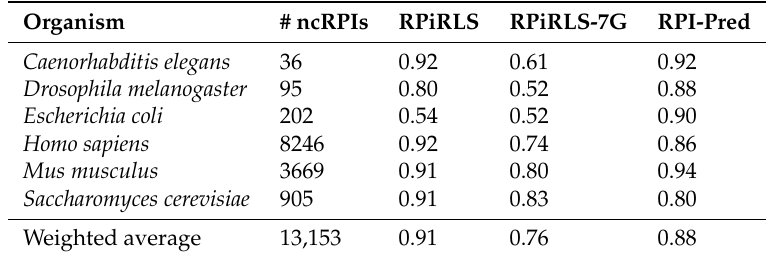
Table 6. Comparing the accuracy of RPiRLS with other methods in predicting non-coding RNA-protein interactions.